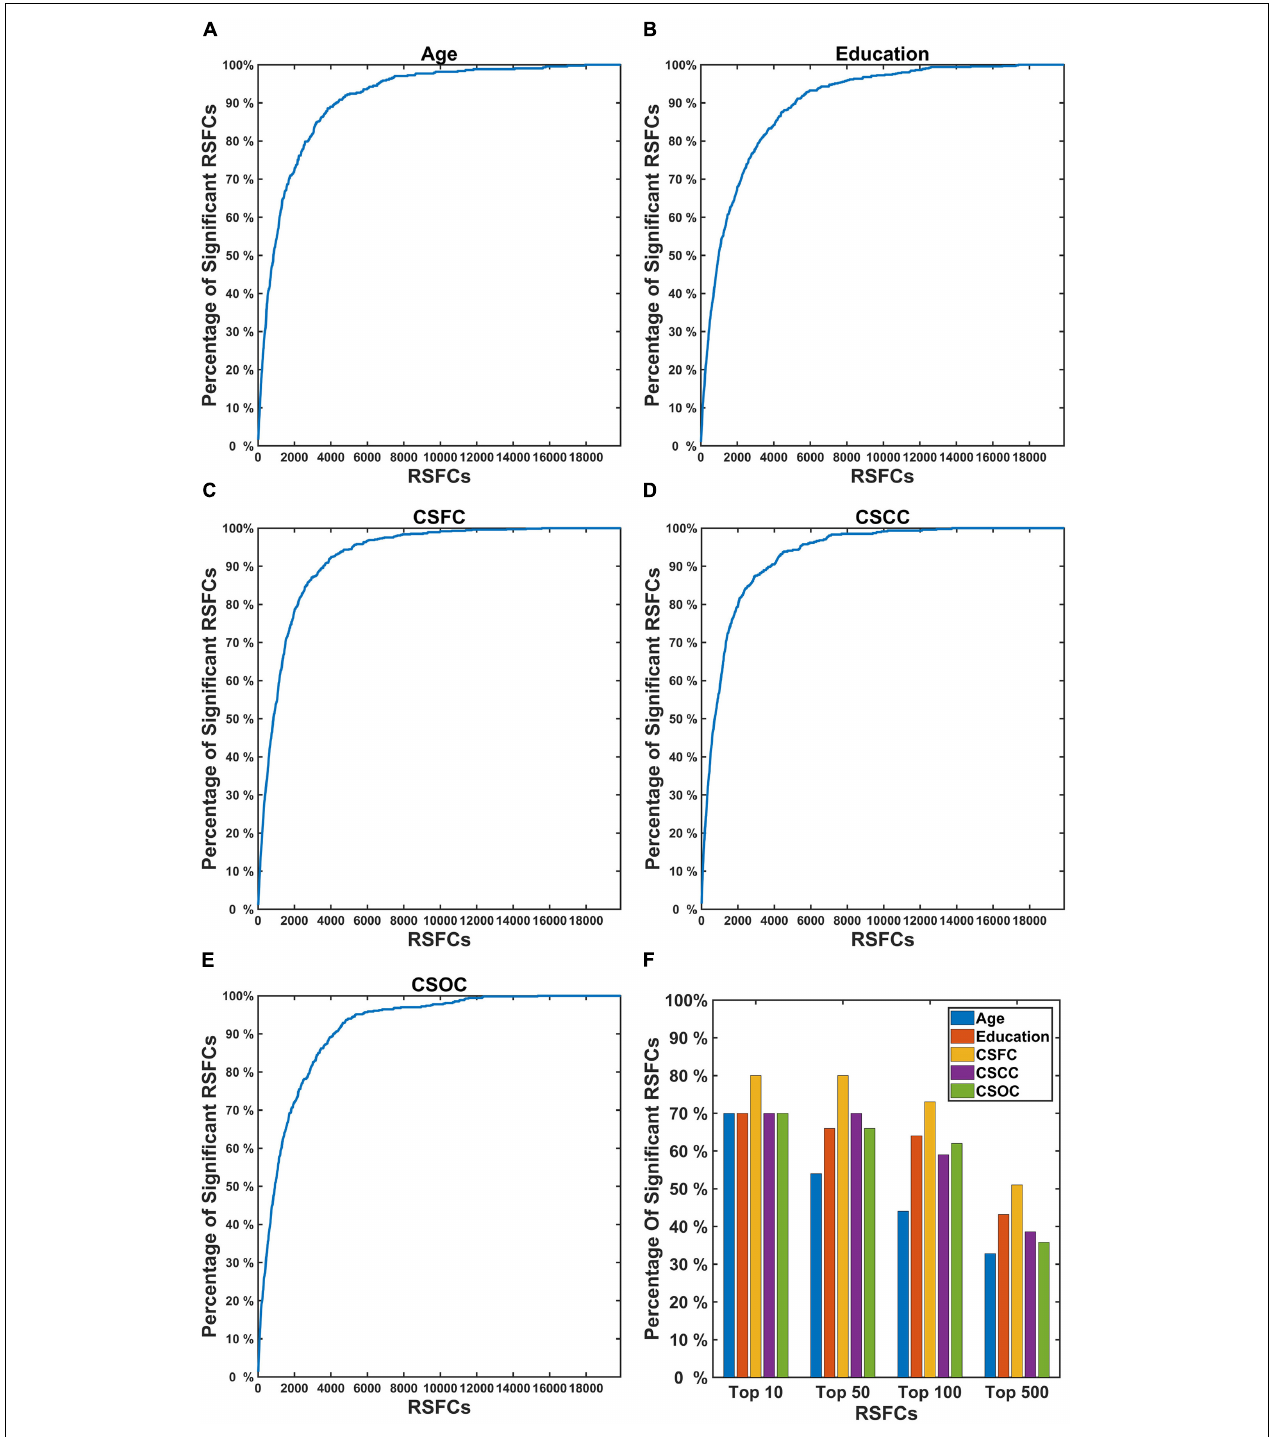
FIGURE 8 | Percentage of RSFCs that made significant contributions to the estimations of a CBD variable among the RSFCs that strongly correlated with that variable. In the first five subplots (A–E) , the X coordinate indicates the sequence number of the correlation (absolute value, sorted in descending order) between the RSFCs and the CBD variable [ (A) for Age, (B) for Education, (C) for CSFC, (D) for CSCC, and (E) for CSOC]; the Y coordinate indicates the percentage of RSFCs that made significant contributions to that variable (among all RSFCs that made significant contributions to that variable). (F) Represents the percentage of RSFCs that made significant contributions to the estimations among the top 10, 50, 100, and 500 RSFCs that were most correlated with the CBD variable. The results were obtained based on the first set of estimations. A large percentage of the RSFCs that contributed to the estimation of a CBD variable were observed to have strong correlation with that